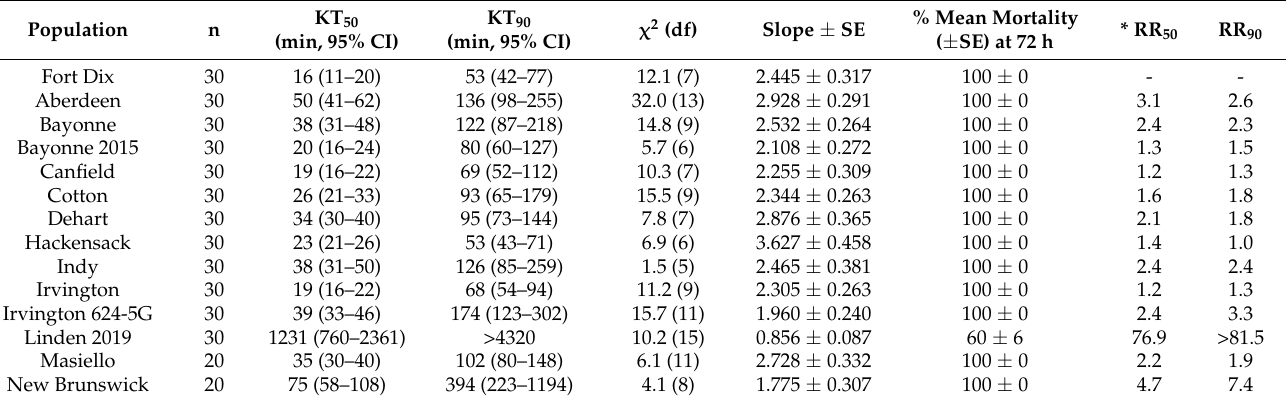
Table 3. Susceptibility (based on knockdown time, KT 50 and KT 90 ) of 13 field-collected C. lectularius populations to topically applied imidacloprid at a discriminating dose of 67 ng per